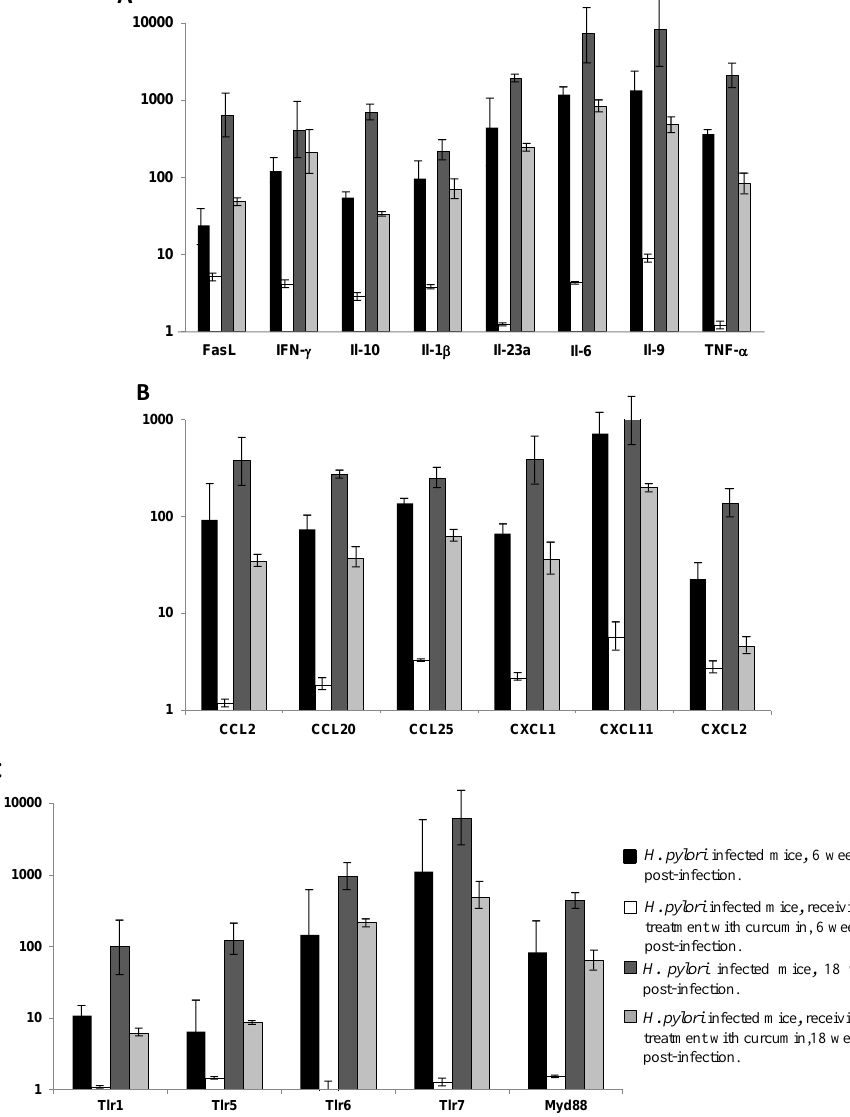
Figure 4. Fold-change in expression of mouse inflammatory response and immunity encoding genes, as determined by PCR arrays and calculated using the 2 −ΔCt method, comparing the Helicobacter pylori -infected non-treated mice and the infected and treated with curcumin mice versus non-infected mice, at Week 6 post-infection and at Week 18 post-infection: ( A ) mouse cytokines; ( B ) mouse chemokines; ( C ) mouse toll-like receptors (TLR) and MyD88. Values denote the means obtained for each of the mice analyzed in each group, each mouse was tested in duplicate (± SD). p < 0.05 for all the comparisons between the infected non-treated and the infected curcumin treated groups except for IFN-γ at Week 18. Values denote the means obtained for each of the three mice analyzed in each group, each mouse was tested in duplicate (±